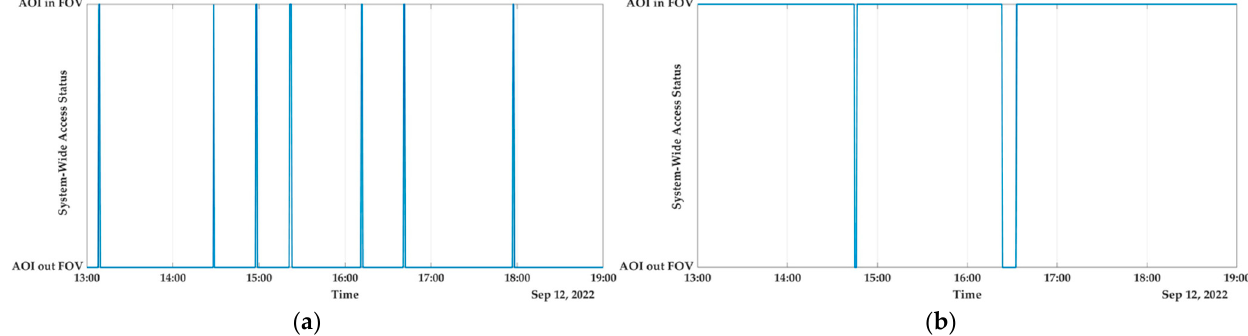
Figure 13. USA: ( a ) system-wide access status; ( b ) system-wide access status with reconfiguration.